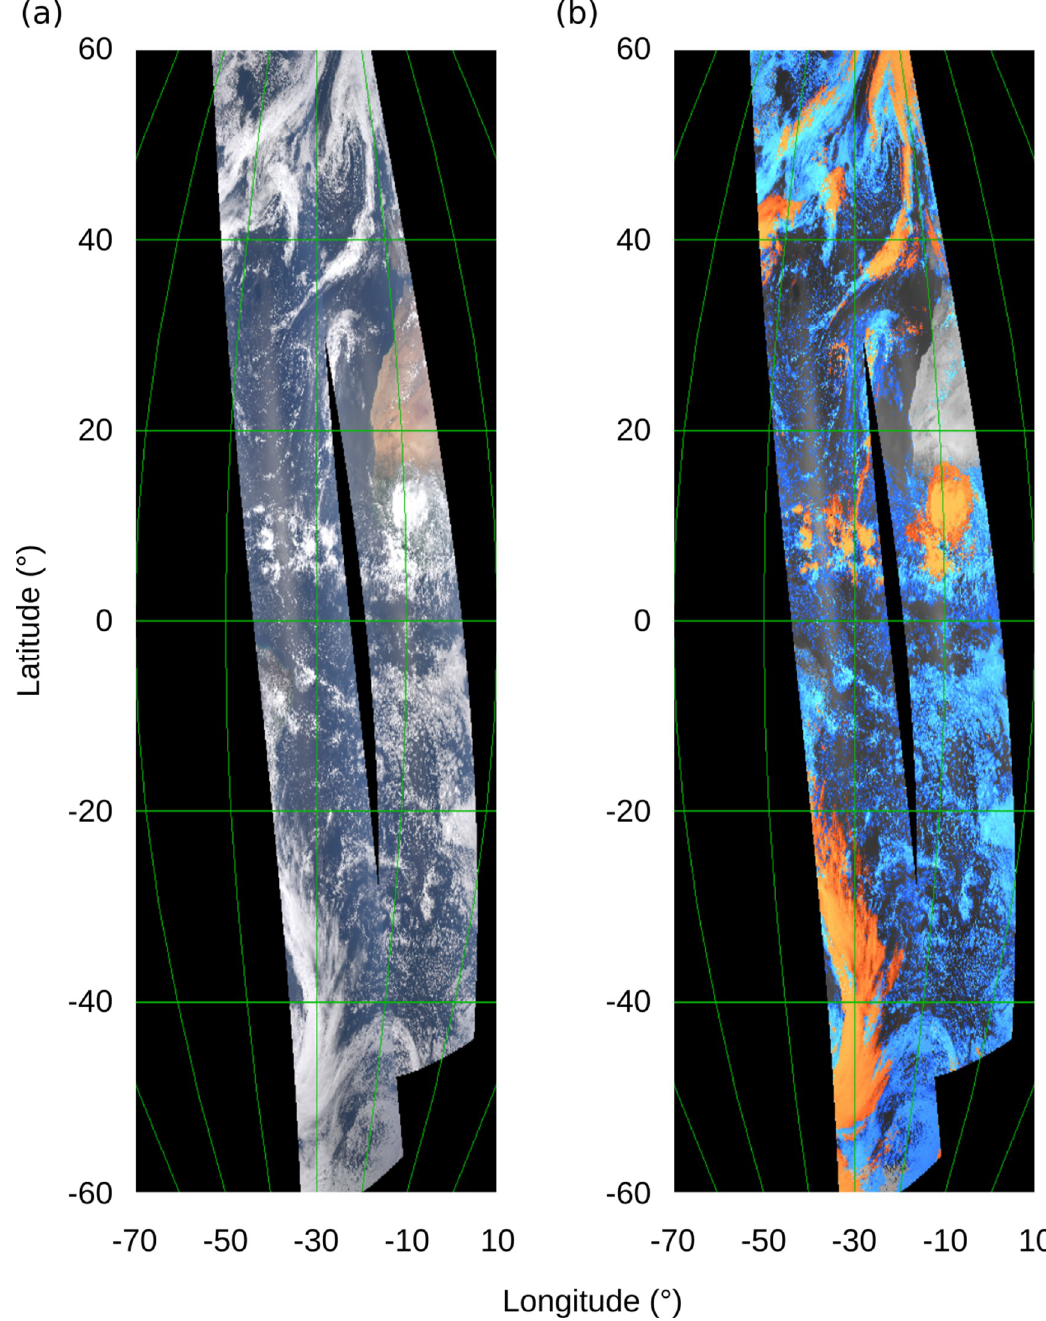
Figure 16. ( a ) Visible composite image of two orbits used in the SW and LW comparison; and ( b ) reflectivity image colored by the MODIS cloud phase. The orange color indicates the clouds are identified as ice clouds.